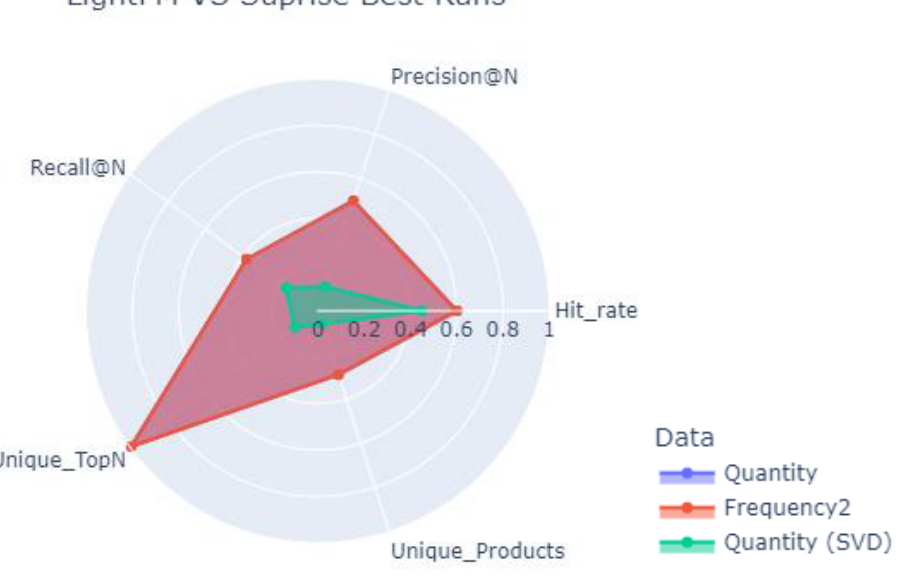
Figure 15. Radar Plot of LightFM in comparison with Surprise